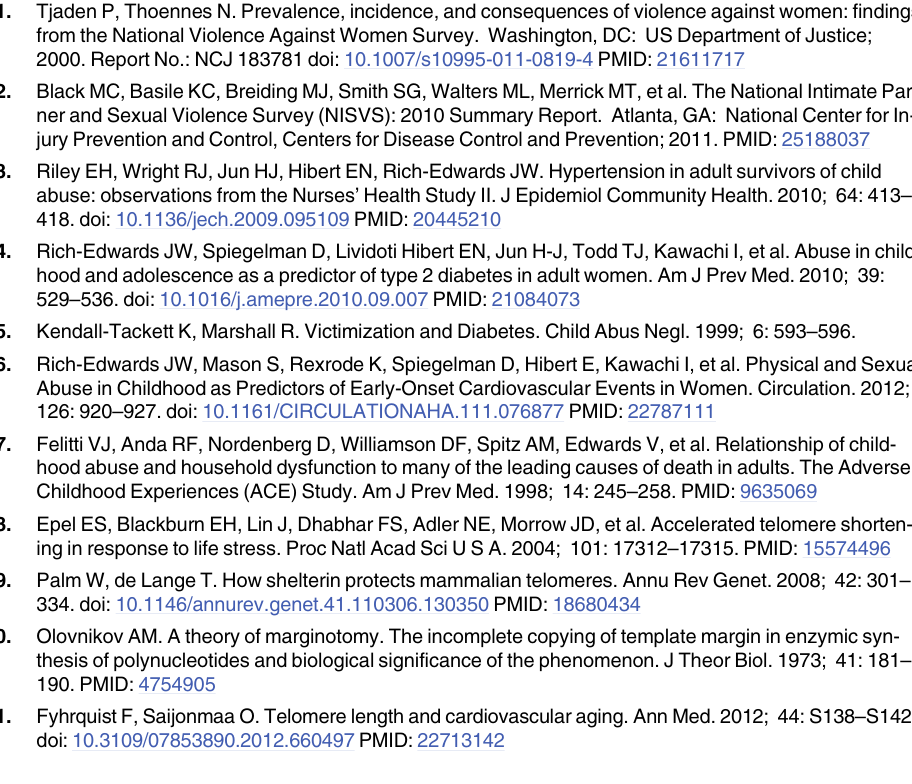
S1 Table. Characteristics of high-violence sample versus control samples from case-control studies. S2 Table. Covariate-adjusted abuse – telomere length associations: Sensitivity analysis re-